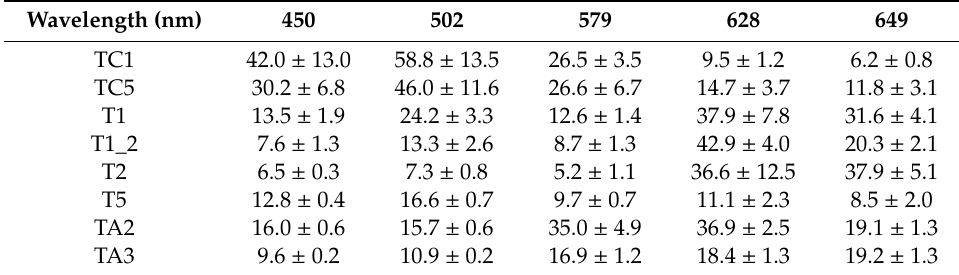
Table 2. Average emission intensity (a.u.) at principal screening wavelengths and their associated standard error, depending on variability of the spectrum within the selected regions of interest (ROIs) and number of fields analyzed within the sample. Only data from some subjects of each group are